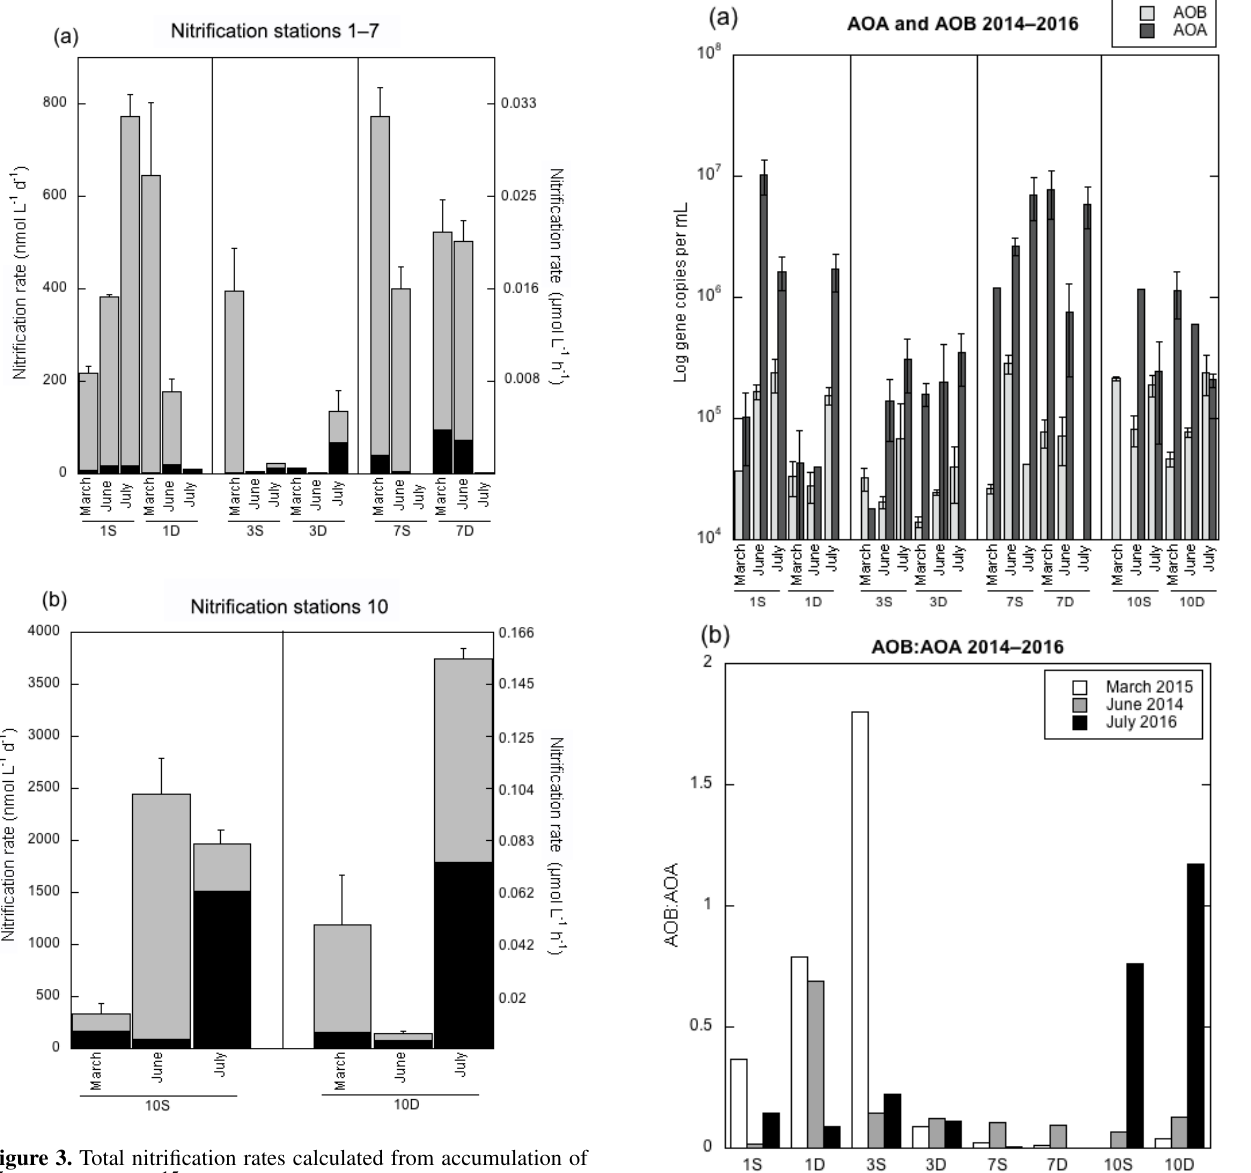
Figure 3. Total nitrification rates calculated from accumulation of 15 NO − (grey) and 15 NO − (black) ± 1 standard deviation. (a) Sta- 2 3 tions 1–7. (b) Station 10. The two axes show different units for total nitrification rates: nmolL − 1 d − 1 and µmolL − 1 h − 1 .